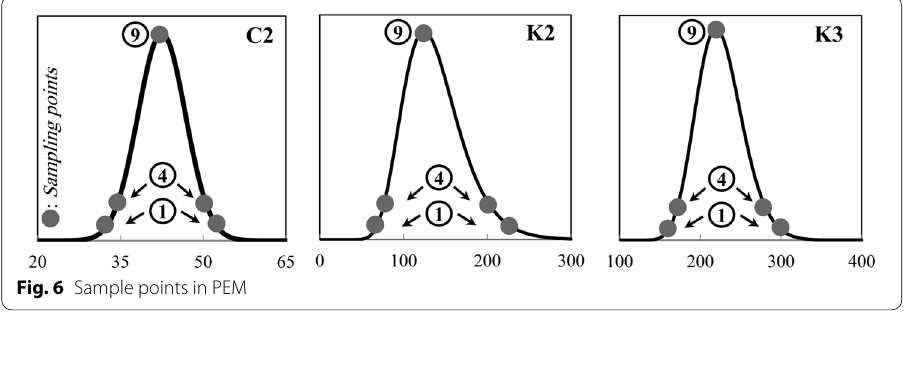
Fig. 6 Sample points in PEM